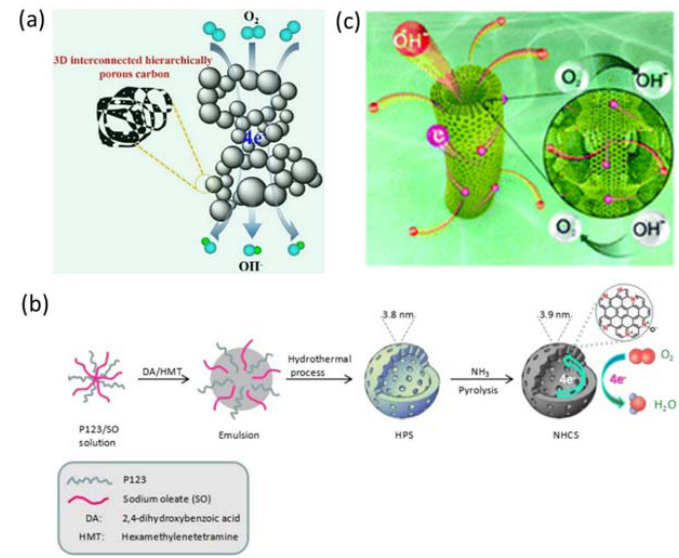
Figure 2. Schematic illustration images of the N ‐ doped carbon ‐ based materials preparation. ( a ) Figure